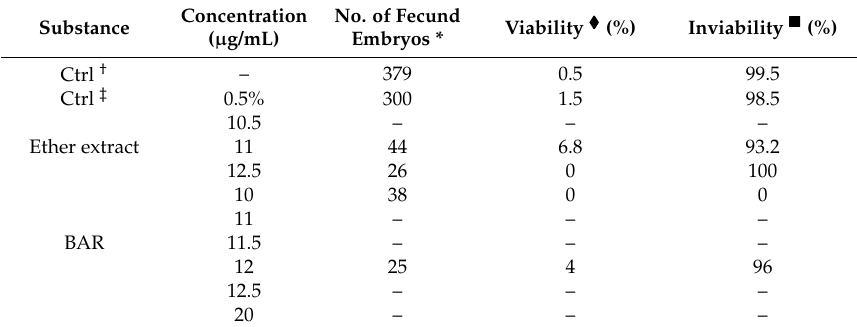
Table 1. Percentage viability and inviability of snail embryos (F1) that survived treatment with the ether extract and